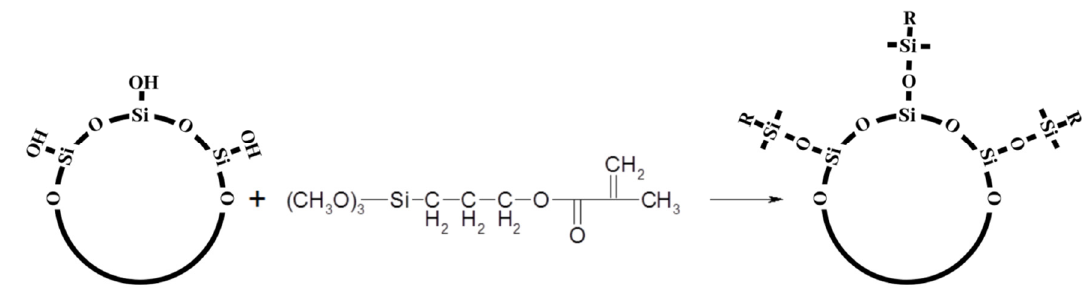
Figure 3. Silanization process of SiO 2 with MPTMS silane. “R” - methacrylate group.